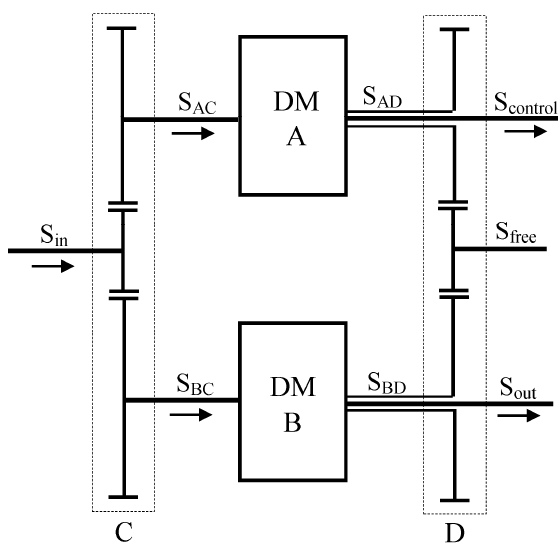
Figure 1. Architecture of the transmission presented by Hwang [31].